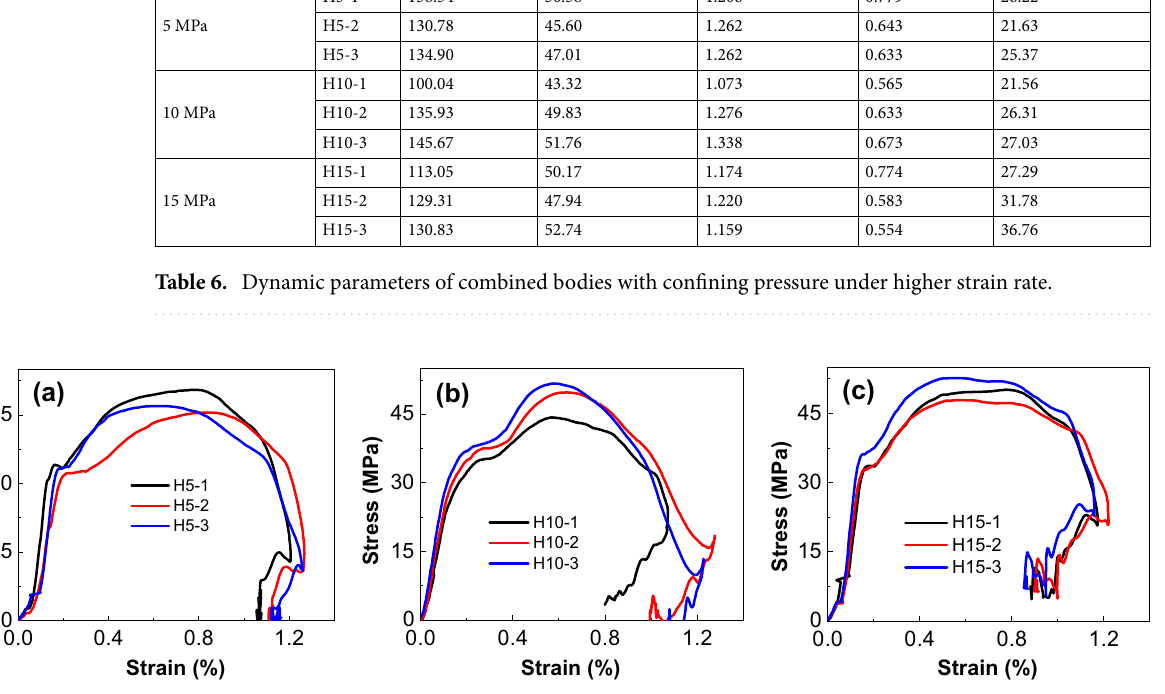
Figure 17. Stress–strain curves of combined bodies with confining pressure under high strain rate. ( a ) 5 MPa, ( b ) 10 MPa, ( c ) 15 MPa. Dynamic parameters of combined bodies under different confining pressures at high strain rate are shown in Table 6. Figure 17 shows stress–strain curves of combined bodies at high strain rate. Stress–strain curves of the bodies all show double-peak under different confining pressures at high strain rate, indicating that the double- peak is mainly related to the dynamic impact loading. In addition, the stress–strain curve with double-peak appears large vibration at the rebound stage under high strain rate, and the amplitude of vibration increases with the increase of strain rate. The occurrence of vibration is closely related to the confining pressure, which is